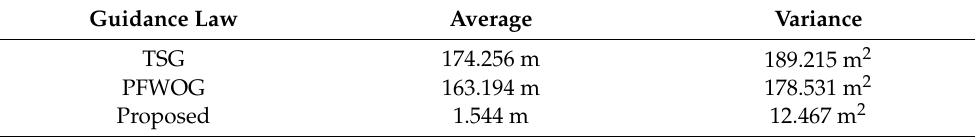
Table 2. Comparison of miss distance statistics under different